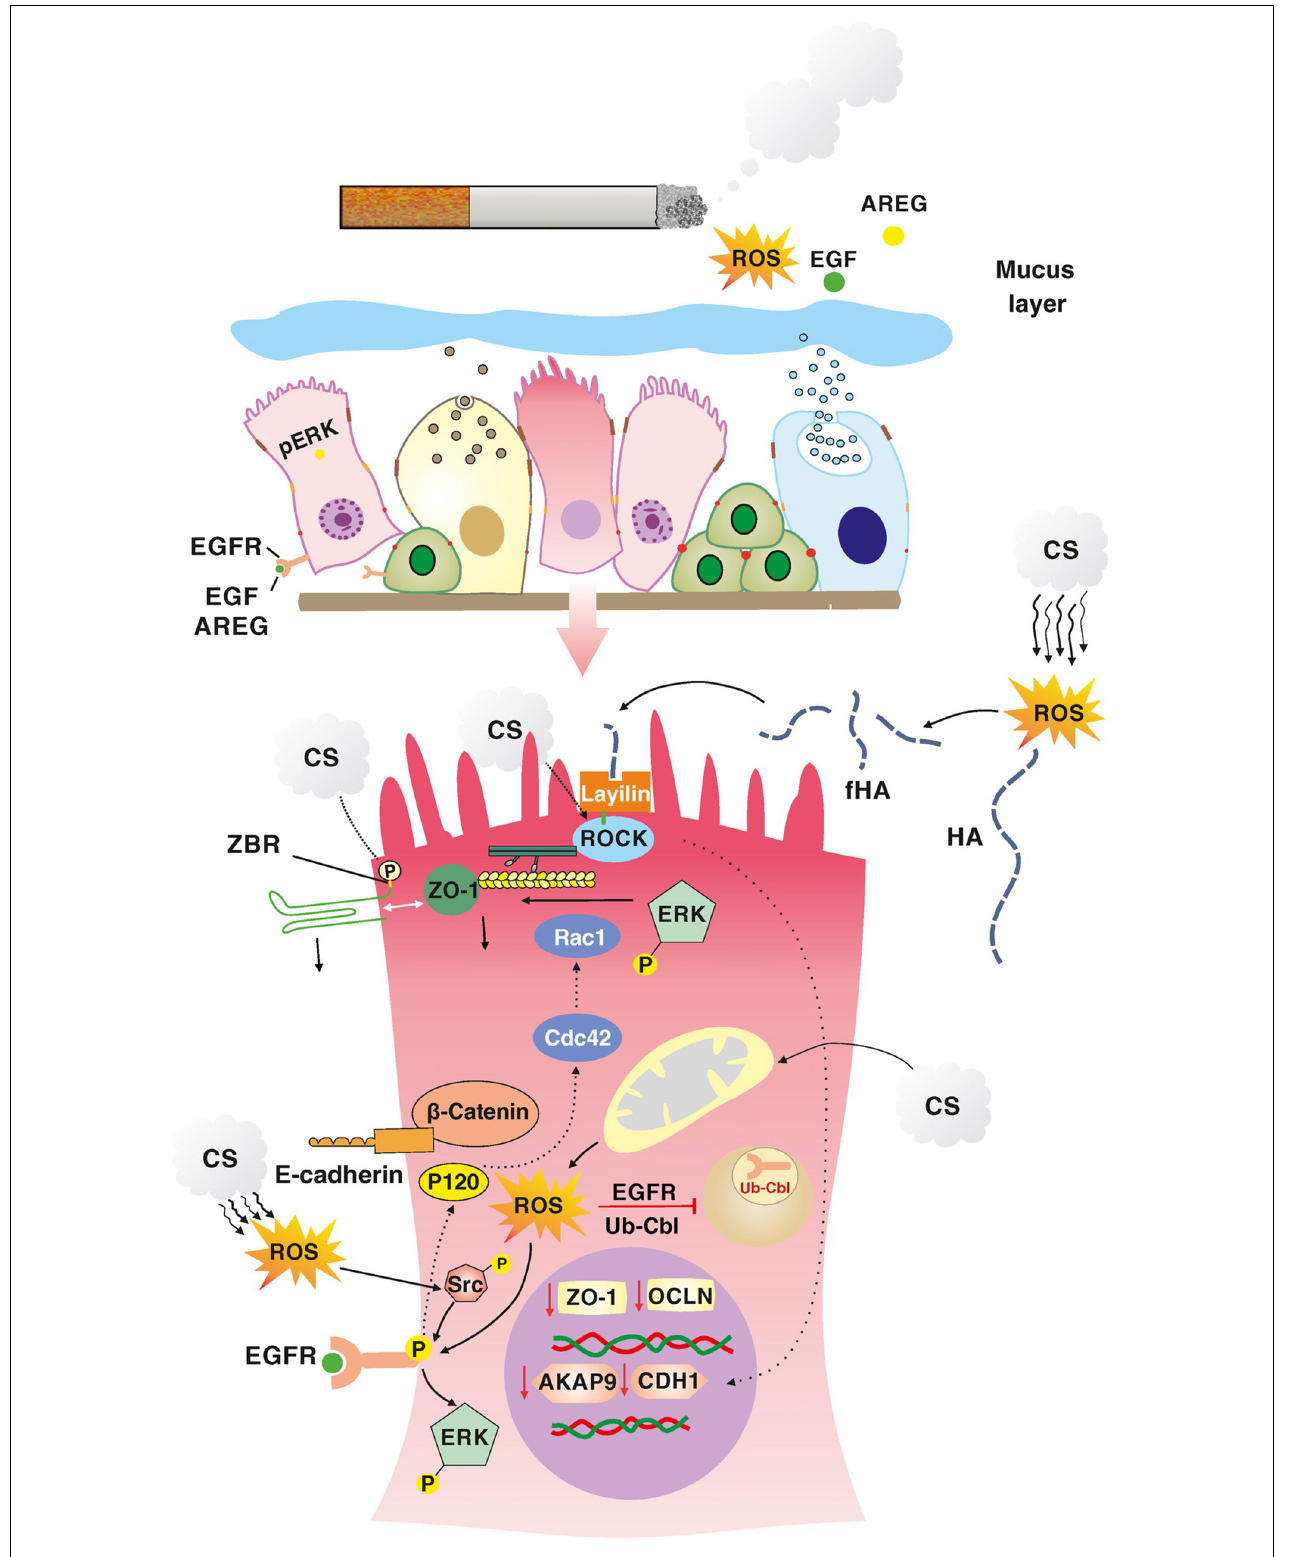
FIGURE 5 | The molecular effect of external noxious on epithelial cell.